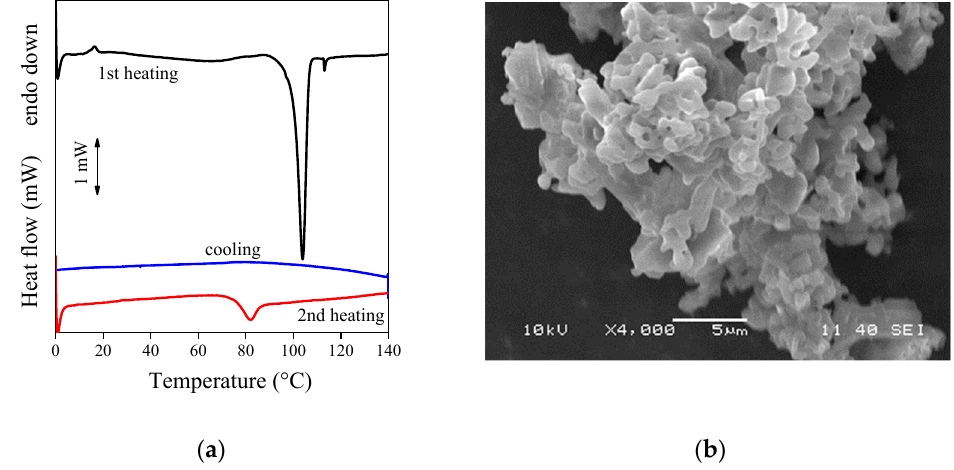
Figure 5. Morphology and thermal behavior of neat valsartan; ( a ) DSC traces recorded on the drug, ( b ) SEM micrograph of the neat drug powder.